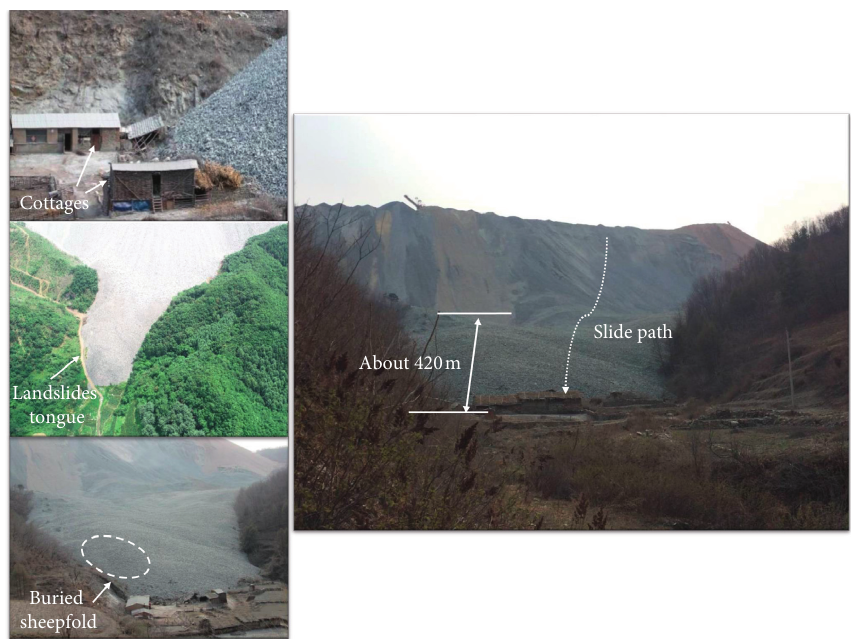
Figure 7: The landslides of the full high waste dump.